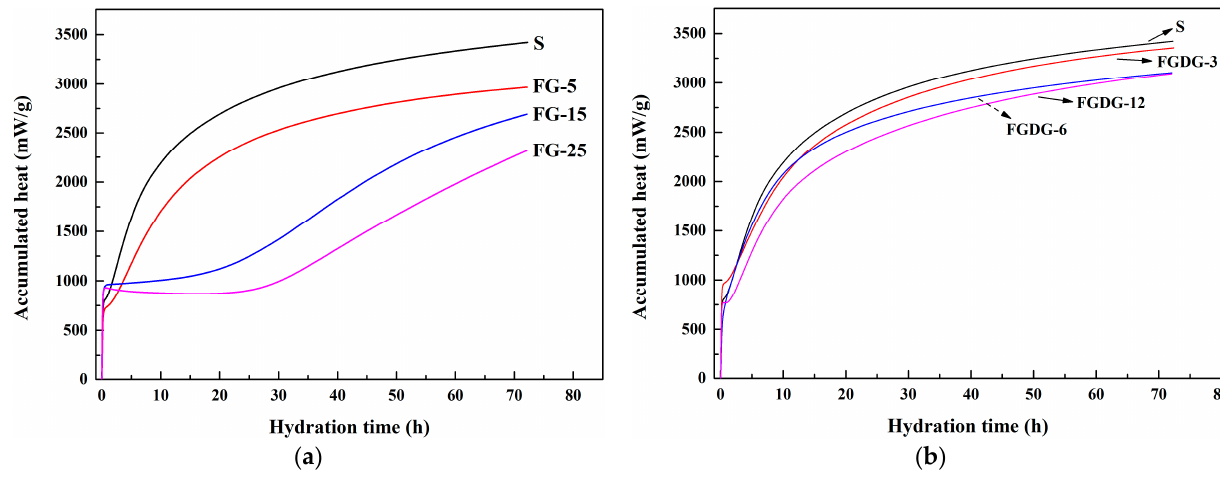
Figure 12. Effect of different gypsum content on accumulated heat of cement paste: ( a ) FG; ( b ) FGDG.